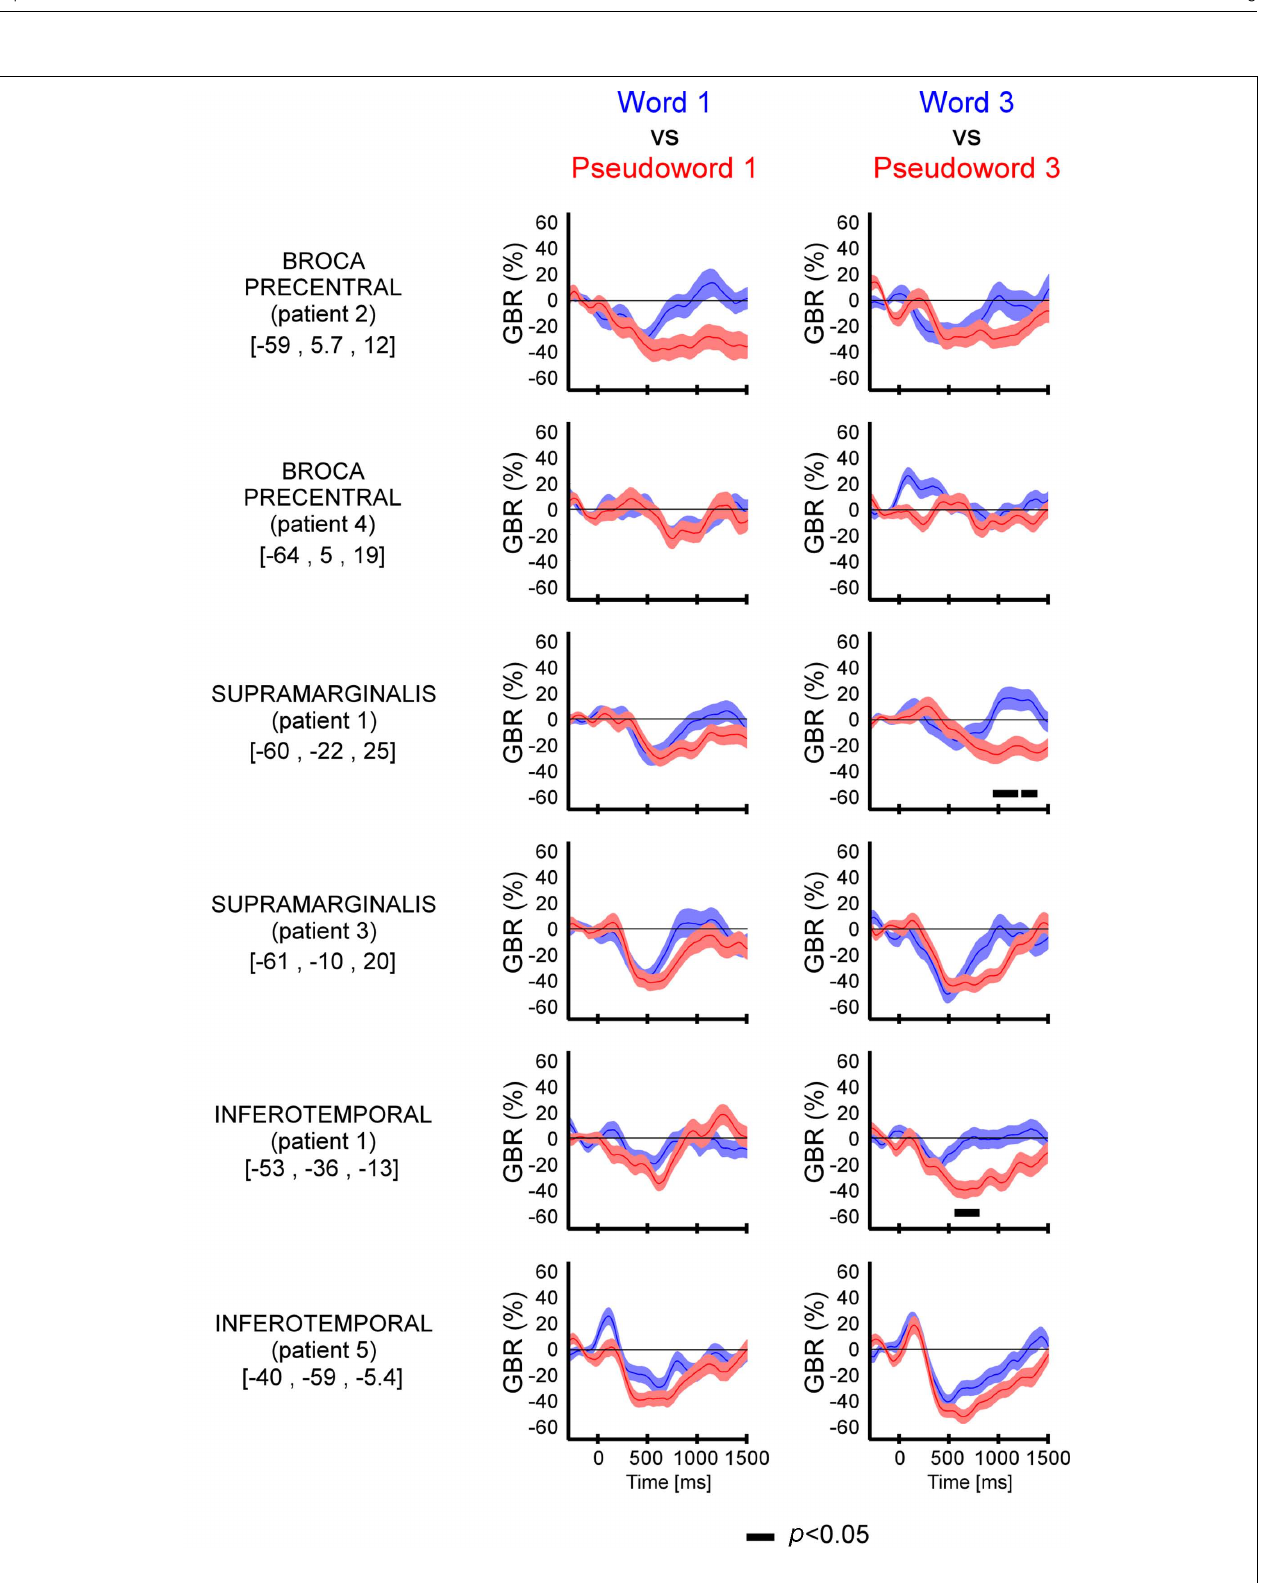
FIGUREA5 | Lexicality effect (W vs. PW) on alpha-band responses recorded in ITOC, Broca’s, and SMG from across patients (1–5). The black line underneath the curves indicates the time samples when the lexical conditions were significantly different ( p < 0.05, Kruskal–Wallis, FDR